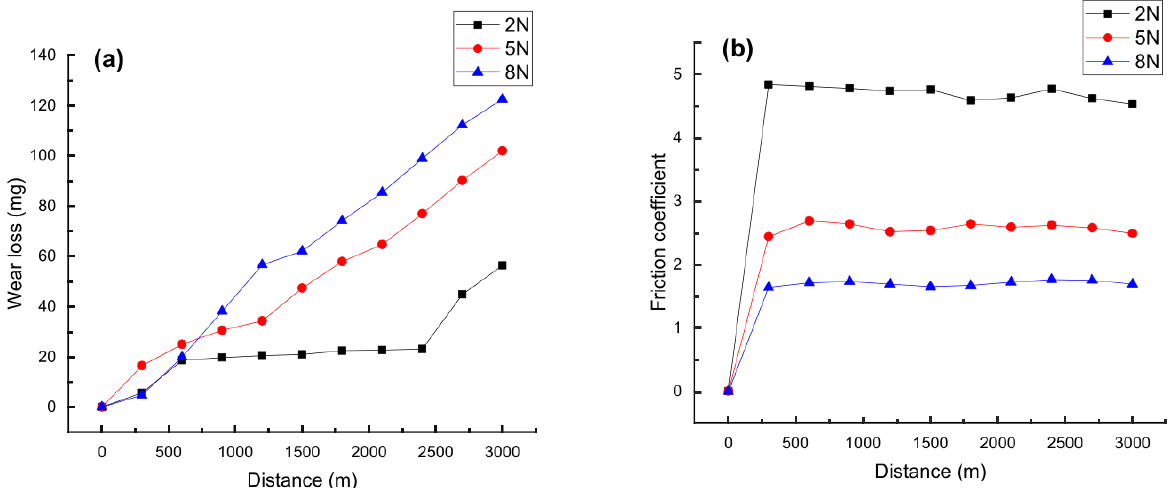
Figure 4. Variations of wear loss and friction coefficient with the sliding distance under different loads (300 r/min, loam, moisture 0): ( a ) wear loss and ( b ) friction coefficient.